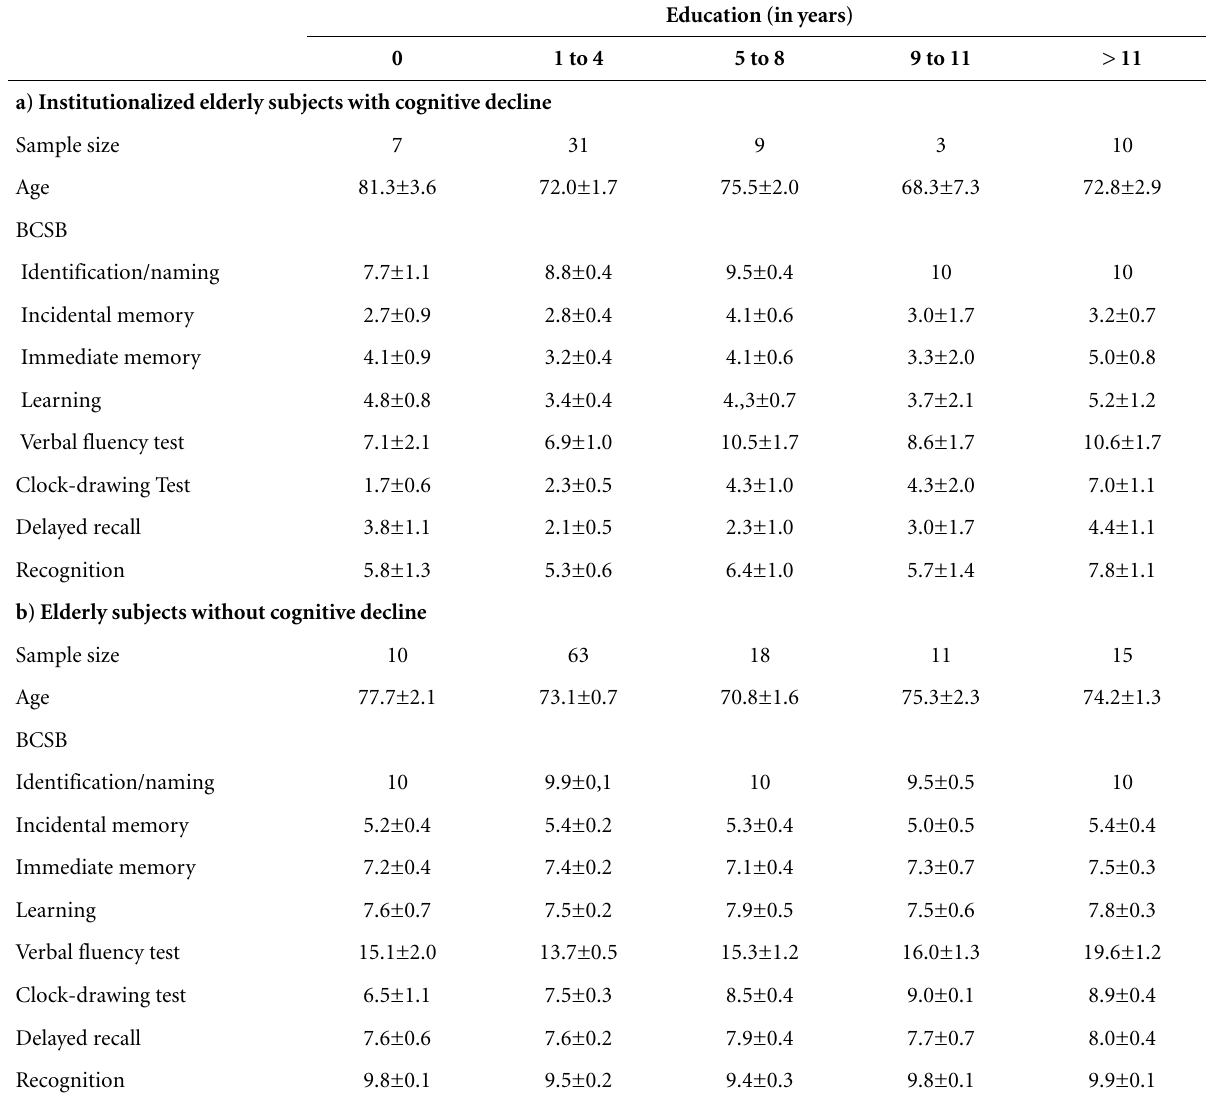
Table 1. Descriptive statistics (mean and standard deviation) of age and BCSB according to educational levels of: a) 60 institutional- ized elderly subjects with cognitive decline; and b) 116 elderly subjects without cognitive